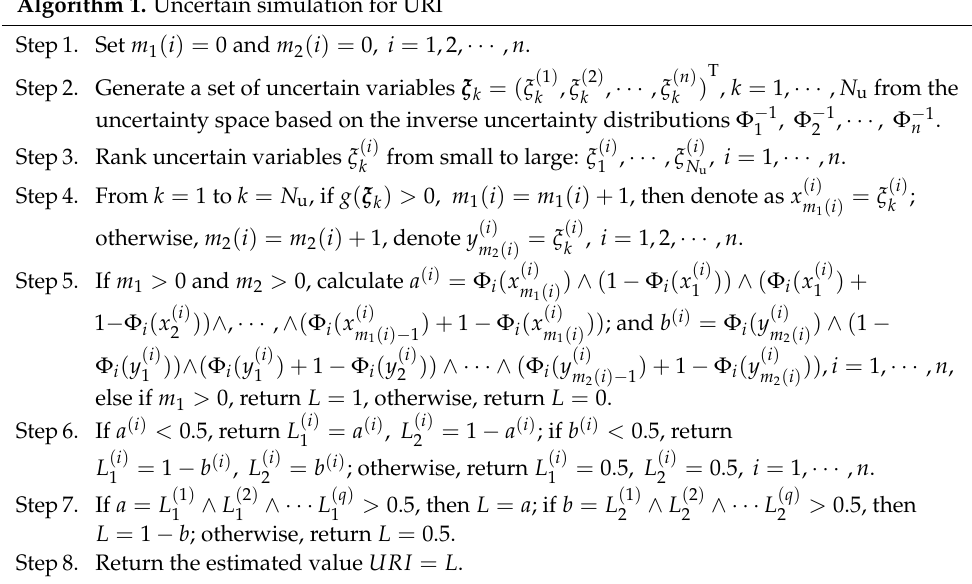
Algorithm 1. Uncertain simulation for